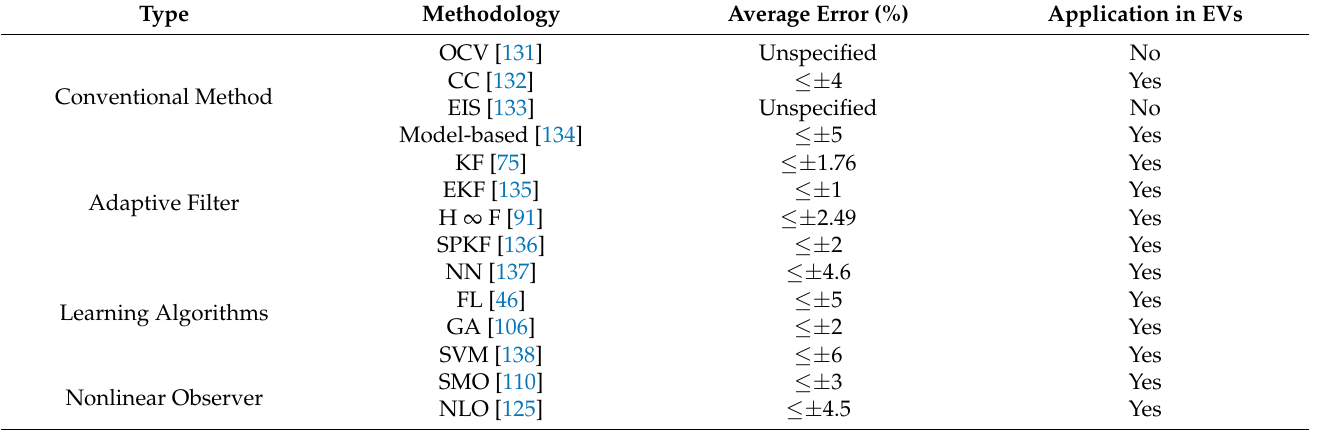
Figure 15. Table 12 summarizes the different SOC estimation methods for Li-ion batteries. Table 11. Comparisons of average error (%) on different SOC estimation